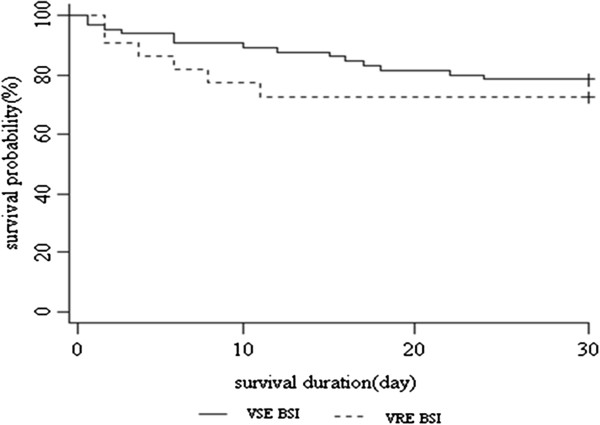
Kaplan-Meier curves for survival. Kaplan–Meier curves for survival during episodes of bloodstream infections (BSIs) with vancomycin-resistant enterococci (VRE) versus vancomycin-susceptible enterococci (VSE) (Log rank test, P = .509).